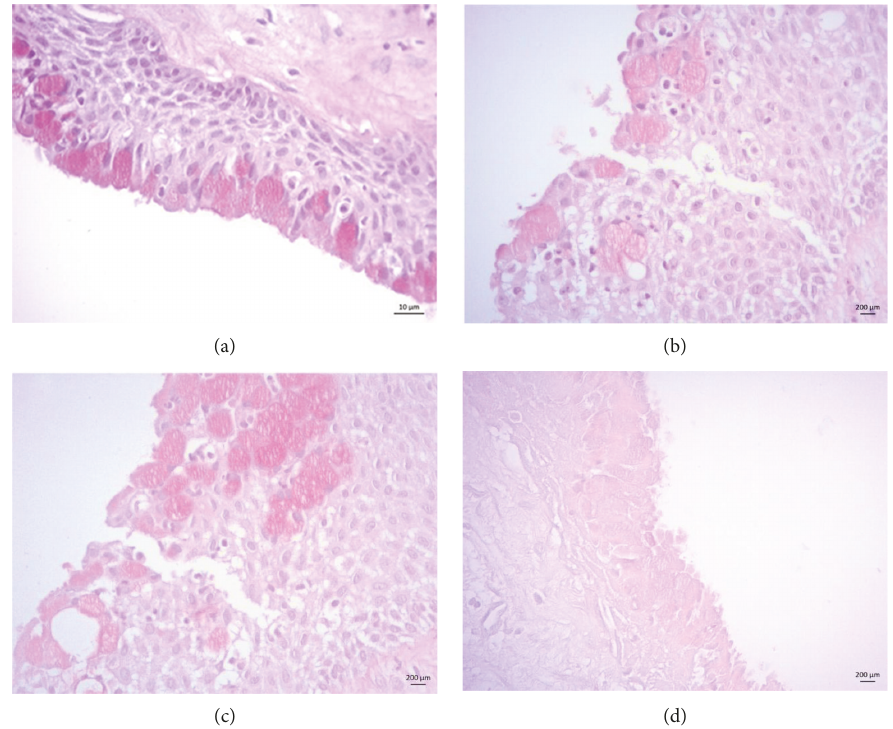
Figure 3: Special stains for GOC. (a, b) Periodic acid-Schi ff - (PAS-) and periodic acid-Schi ff diastase- (PAS-D-) positive goblet cells showing glycogen-rich cells. (c) Note the glandular-like structure stained by PAS-D. Mucin-secreting cells were also identi fi